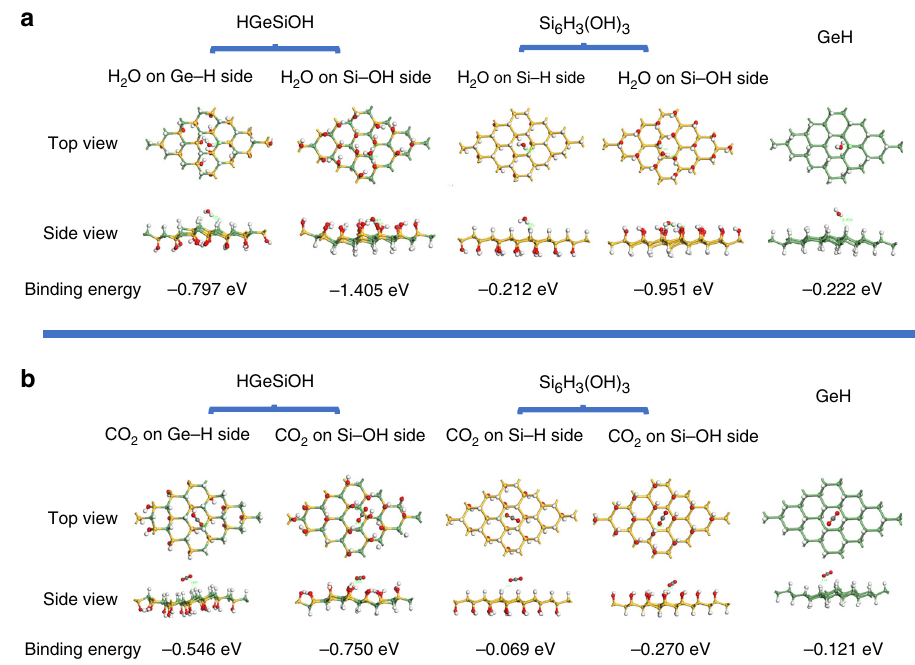
Fig. 7 The DFT calculations on adsorption energies. a , b Optimized geometric structures and binding energies for H 2 O ( a ) and CO 2 ( b ) adsorption on HGeSiOH, Si 6 H 3 (OH) 3 , and GeH